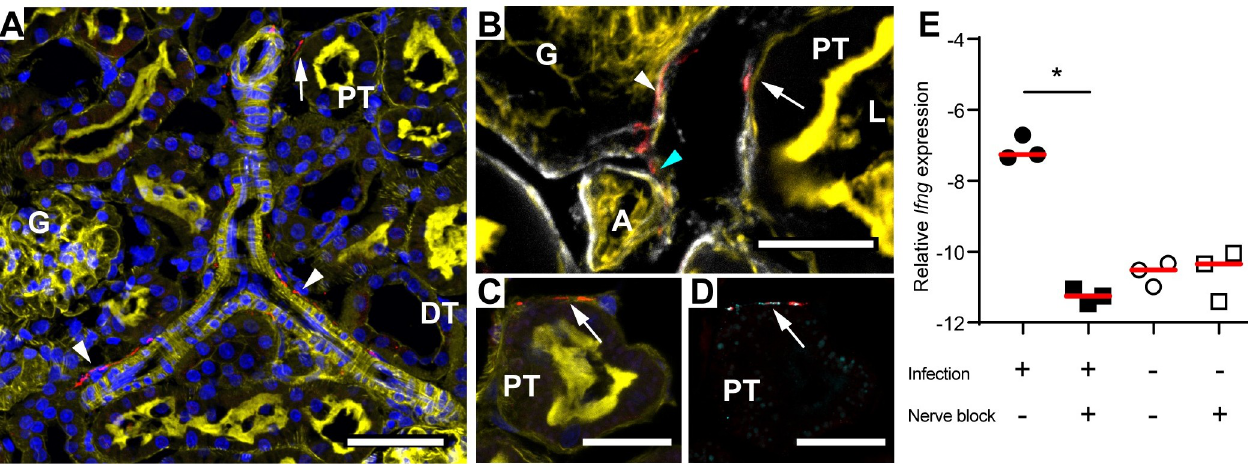
Fig 2. Nervous signalling is required for inter-organ communication. ( A-D ) Ex vivo confocal microscopy of rat kidney. ( A ) Actin (yellow) and Hoechst stain (blue) show proximal tubules (PT), distal tubules (DT), and glomerulus (G). β 3-tubulin (red) shows nerve fibres surrounding the vasculature (arrow heads) as well as at the basal face (arrow) of proximal tubules. Scale bar = 50 μ m. ( B ) Nerve fibres stained by β 3-tubulin (red) co-localize with collagen IV-rich (white) basement membrane of the proximal tubule (arrow), glomeruli (white arrow head), and arteriole (A) (cyan arrow head). L = lumen of proximal tubule. Scale bar = 15 μ m. ( C-D ) Co-staining with (C) the general marker of nerve fibres anti-PGP9.5 (red) and ( D ) the sensory nerve marker anti-TrkA (cyan) locates sensory nerve fibres at the basal face of actin (yellow) rich proximal tubules (arrows). Scale bar = 20 μ m. Images are representative of n = 3. ( E ) mRNA expression of Ifng in splenic tissue after 4 h kidney infection with LT004 (black symbols) or sham-infection (PBS-infused, unfilled symbols), with (squares) or without (circles) nerve block prior to infection. Relative Ifng expression (delta CT) is given in relation to the reference gene Gapdh. Individual data points and median values (red bars) are shown. � = p < 0.05 determined by Kruskal-Wallis analysis and Dunn’s correction, n = 3 for each group.